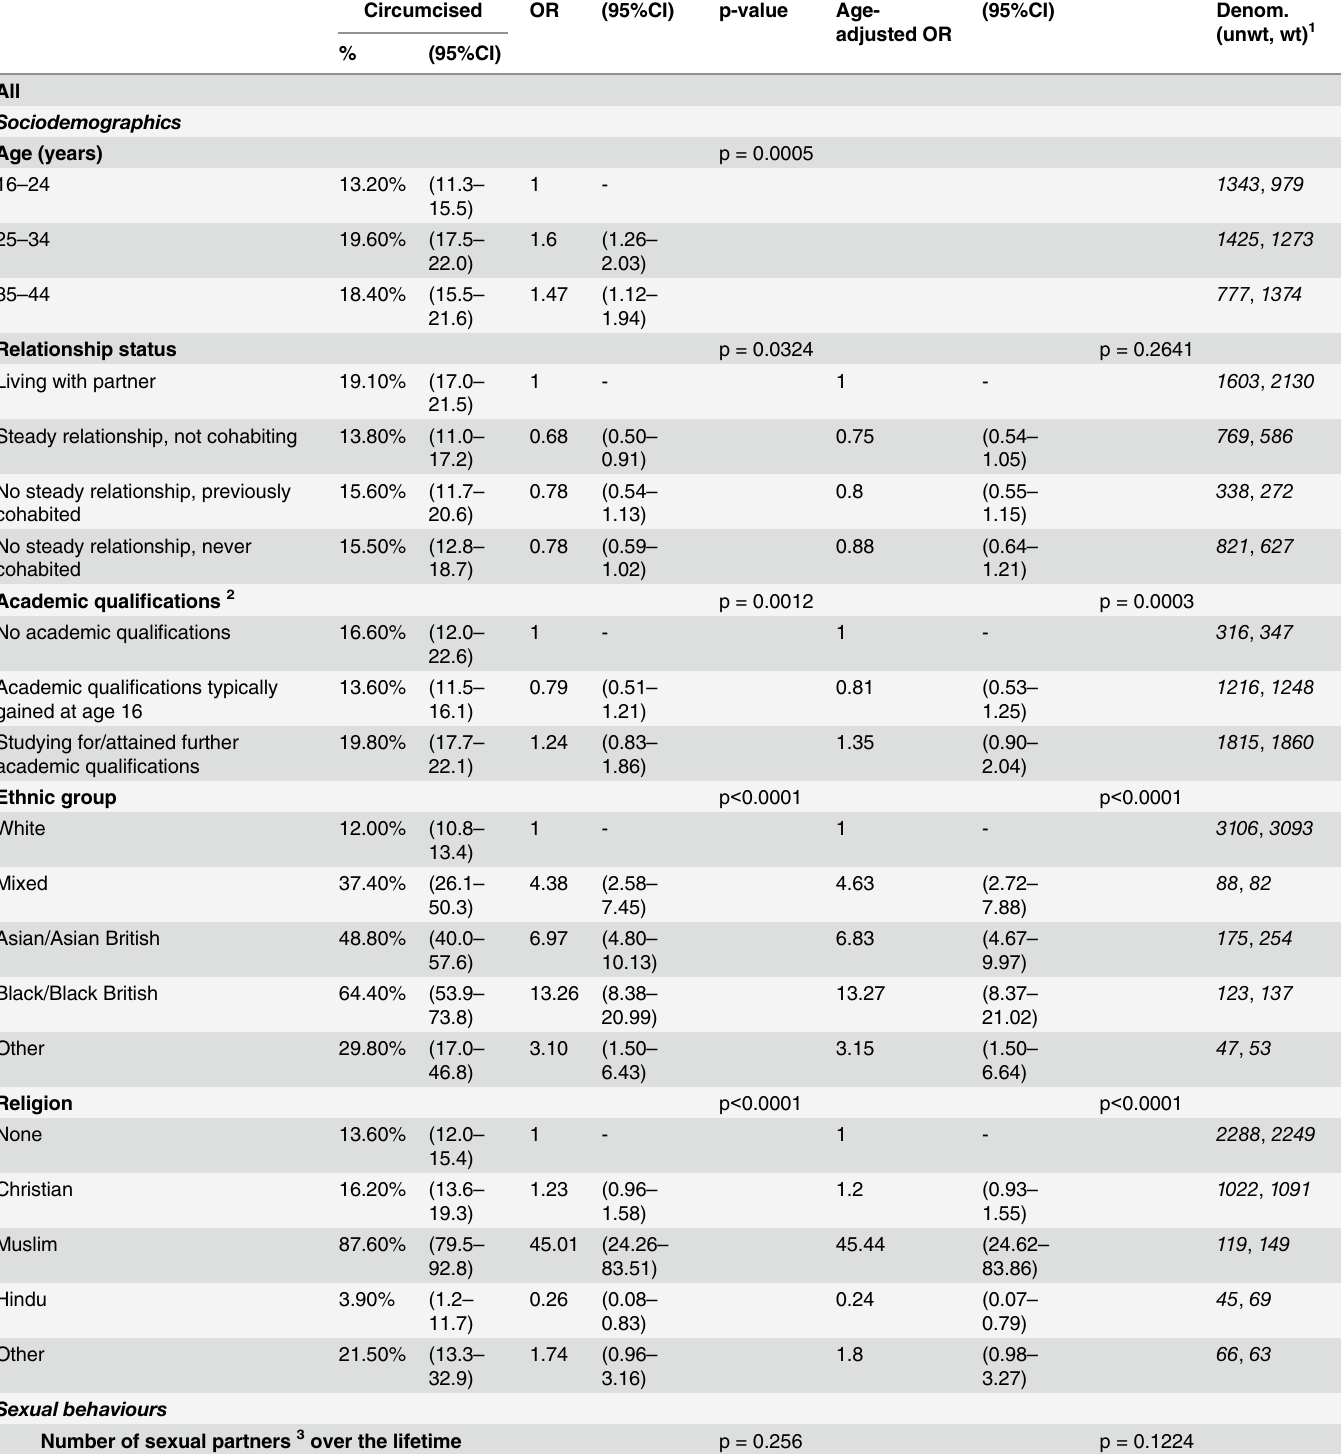
Table 1. Variations in the prevalence of circumcision by key sociodemographic factors and sexual behaviours reported by sexually – experienced 1 men aged 16 – 44 years in Britain ’ s third National Survey of Sexual Attitudes and Lifestyles